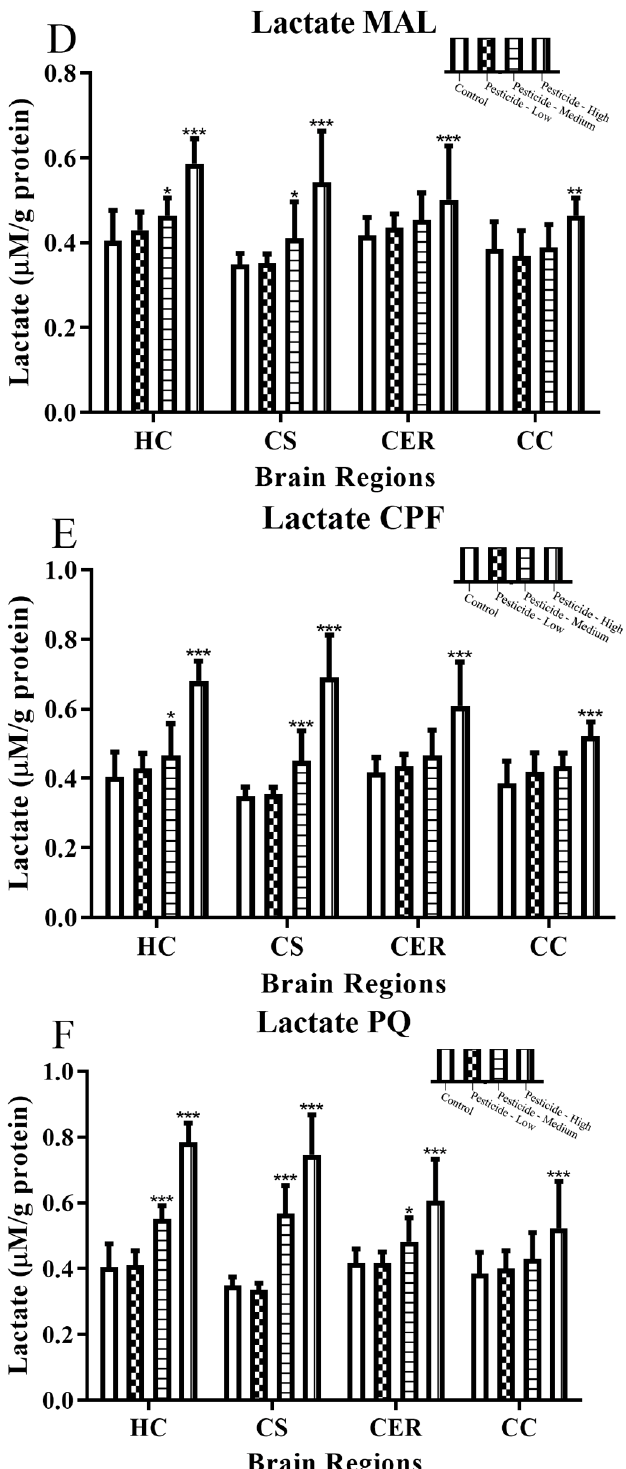
Figure 4. Pesticide-induced inhibition of ATP levels and lactate production. Rats were dosed with malathion (MAL) ( A , D ); chlorpyrifos (CPF) ( B , E ); or paraquat (PQ) ( C , F ) at low, medium, or high dosages and the levels of cellular ATP and lactate quantified within the hippocampus (HC), corpus striatum (CS), cerebellum (CER), and cerebral cortex (CC). Histograms are representative of mean values with SDs, with significant changes marked with asterisks, according to * p < 0.05, ** p < 0.01, and *** p <